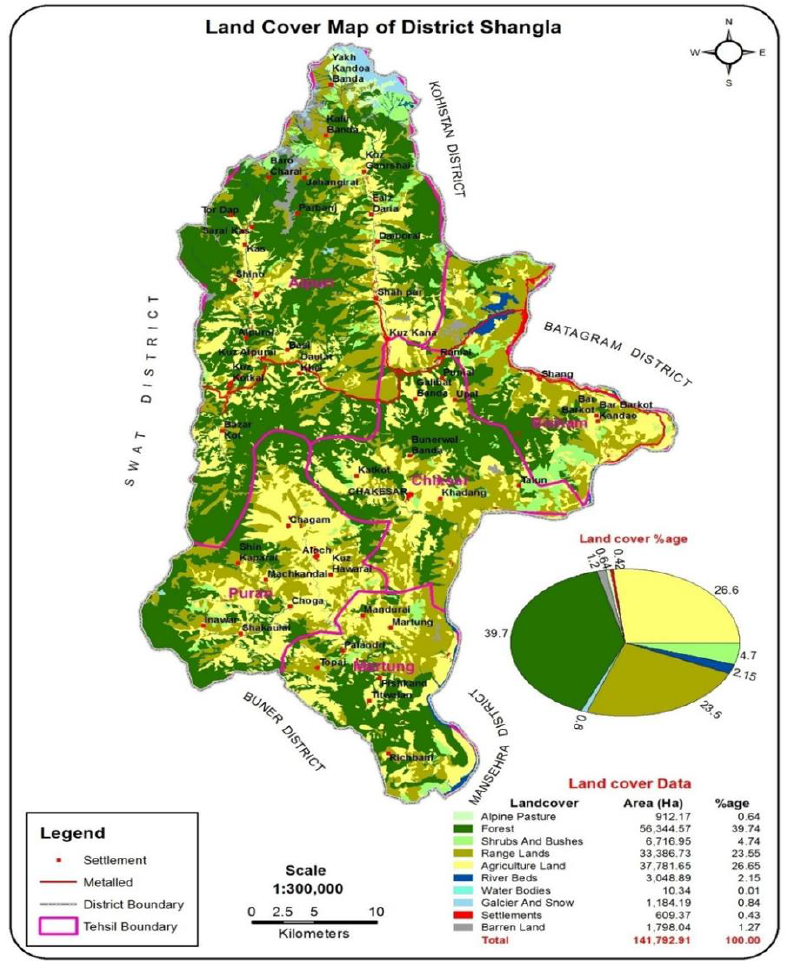
Figure 1. Land cover map of the study